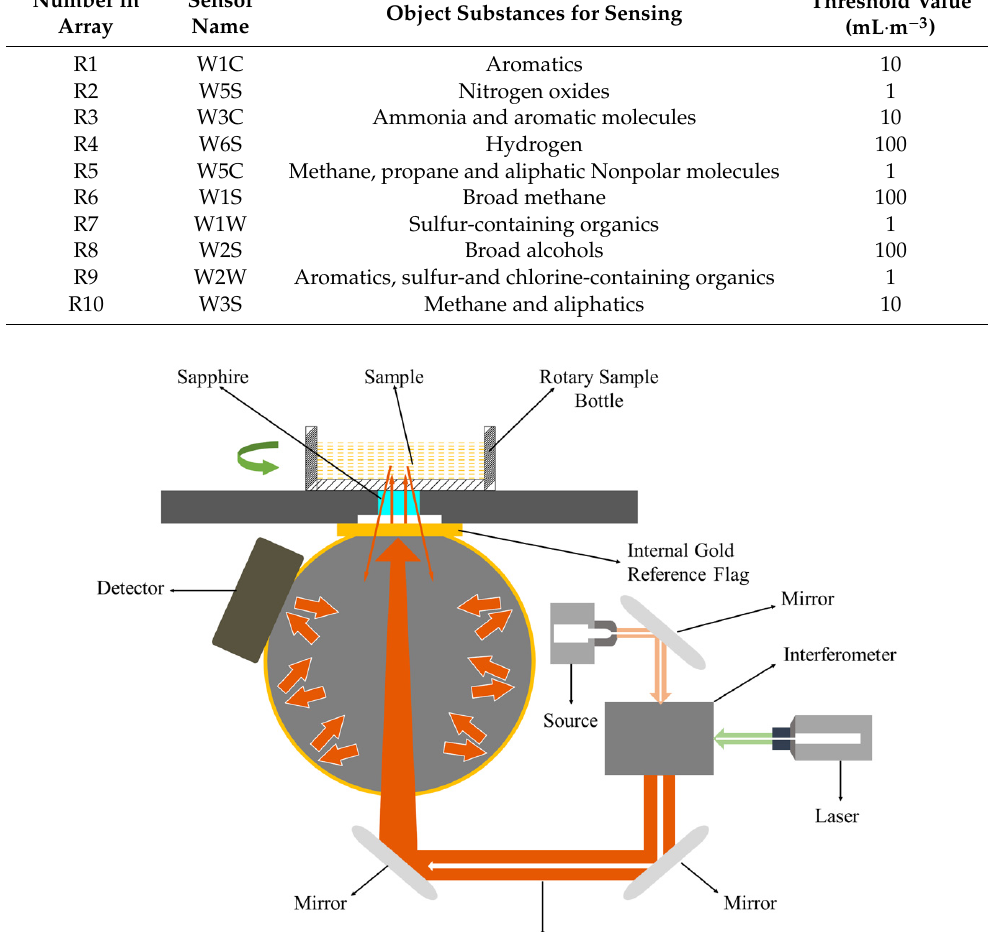
Figure 2. Schematic diagram of the Fourier transform NIR (FT–NIR) system in diffuse reflection measurement mode with the integrating sphere.